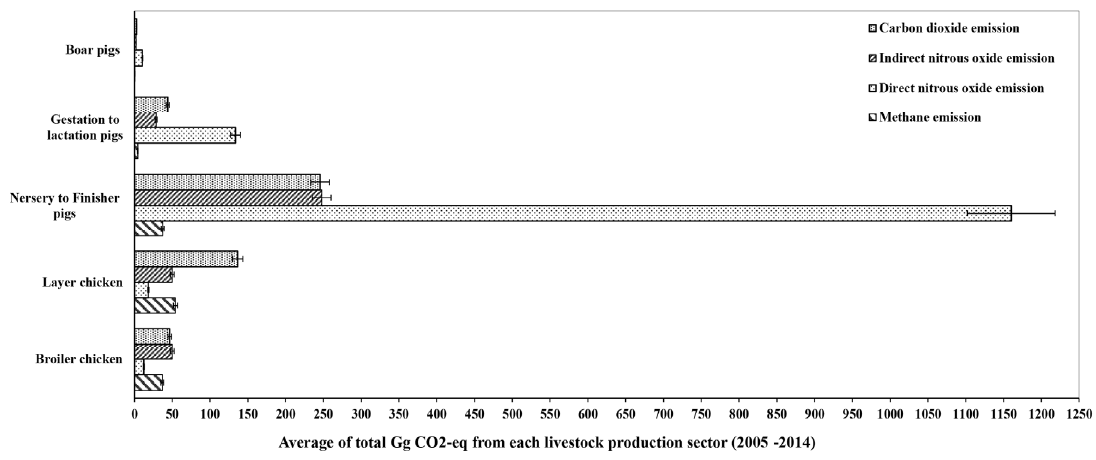
Figure 1. Average greenhouse gases emissions in poultry and pig production unit (from 2005 to